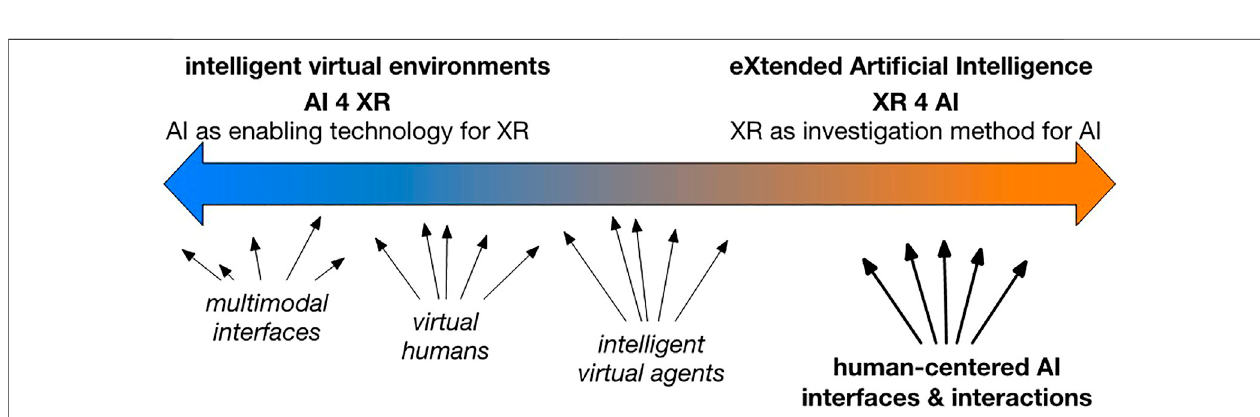
FIGURE 3 | The XR-AI Continuum classi fi es potential XR-AI combination approaches with respect to the main epistemological perspective motivating the combination. The scale ’ s polesdenote approachesthatpurely target AIastheobject ofinvestigation (XR4 AI)or thattarget AIasan enabling technology (AI4XR).Well- knownresearchareaswhichutilizeXR-AIapproachesaredepicedwiththeirpotentialmappingontothescale.Notably,approacheswilloftenservebothperspectivesto various degrees, mapping them to the respective positions between the poles. The established fi elds and terms of intelligent virtual environments and smart graphics/intelligent graphicswill mostlycover theleftspectrumofthecontinuum.Incontrast,theright spectrum,which concentrates on AIastheobject ofinvestigation, is covered by approaches we denote as eXtended Arti fi cial